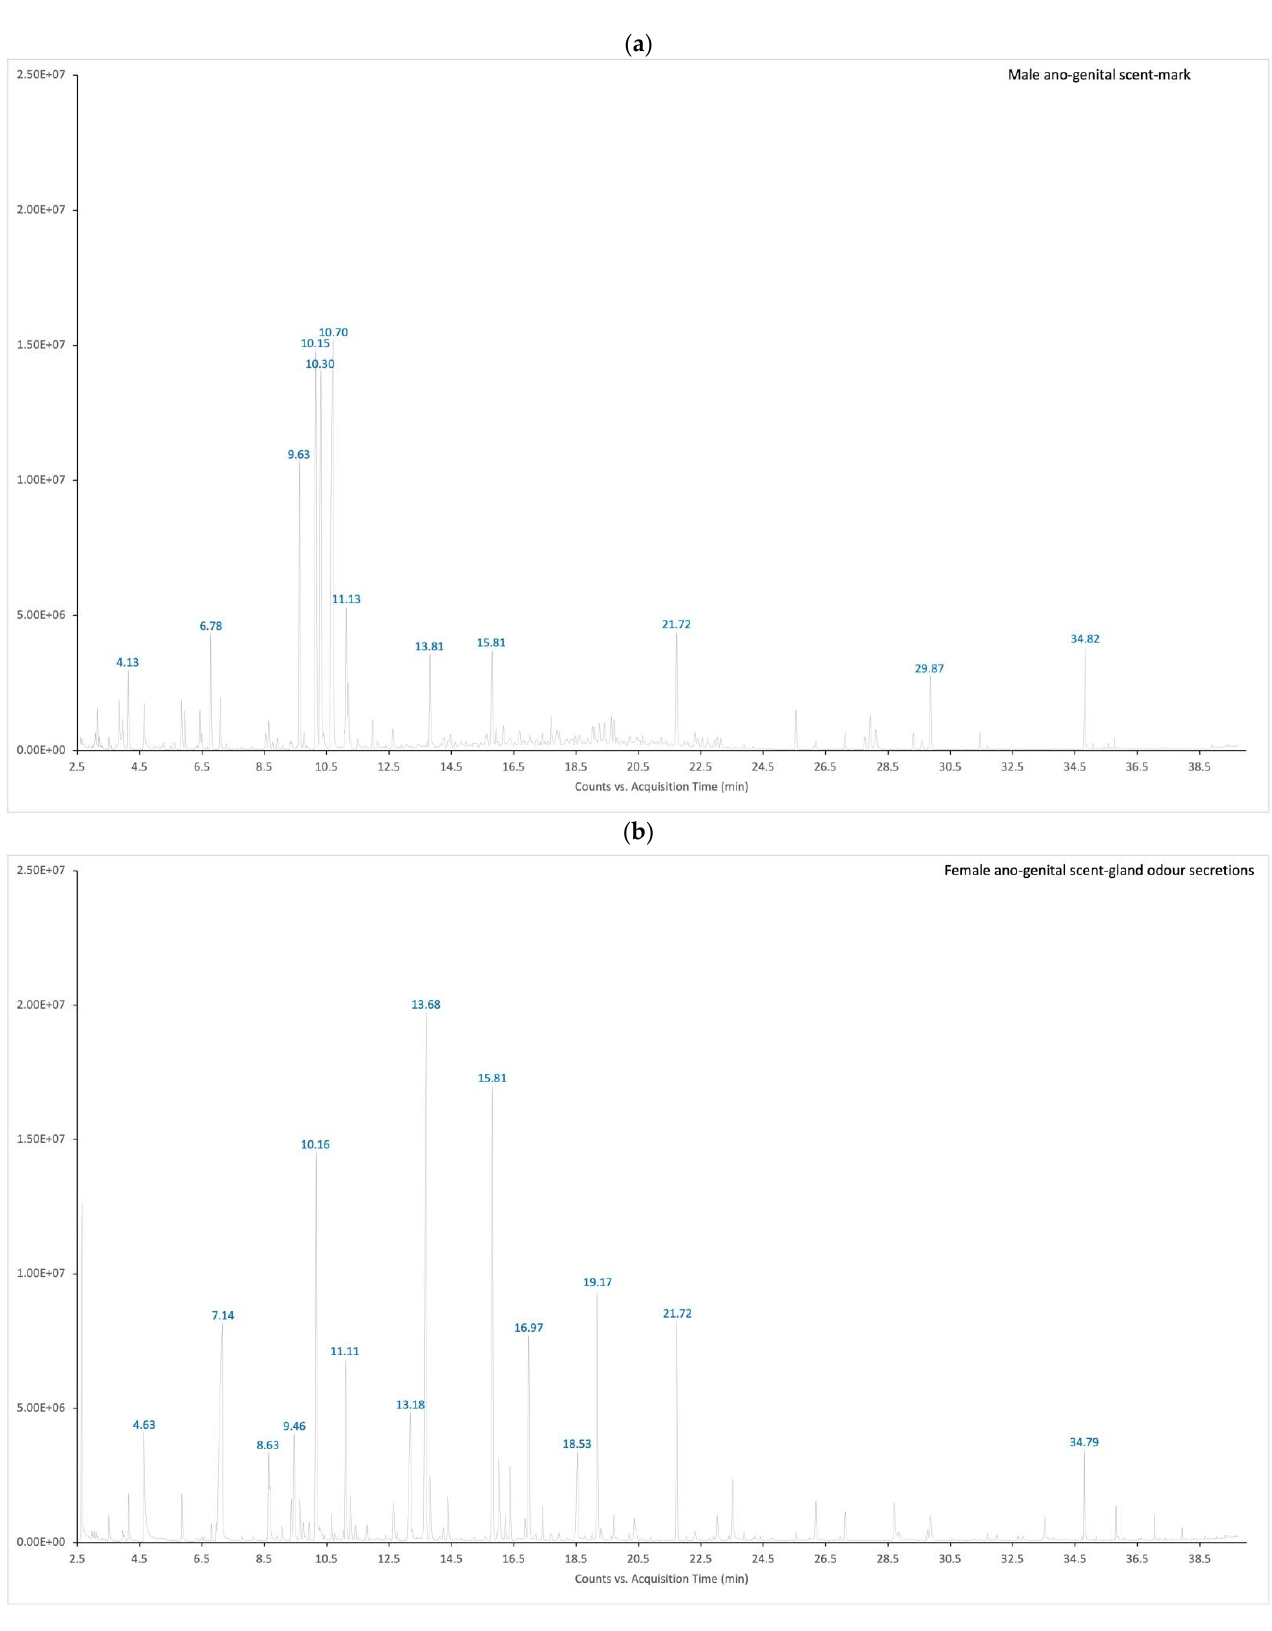
Figure 5. Example chromatogram from ( a ) male crowned lemur, ano-genital scent-mark; and ( b ) female crowned lemur, ano-genital scent-gland odour secretions.